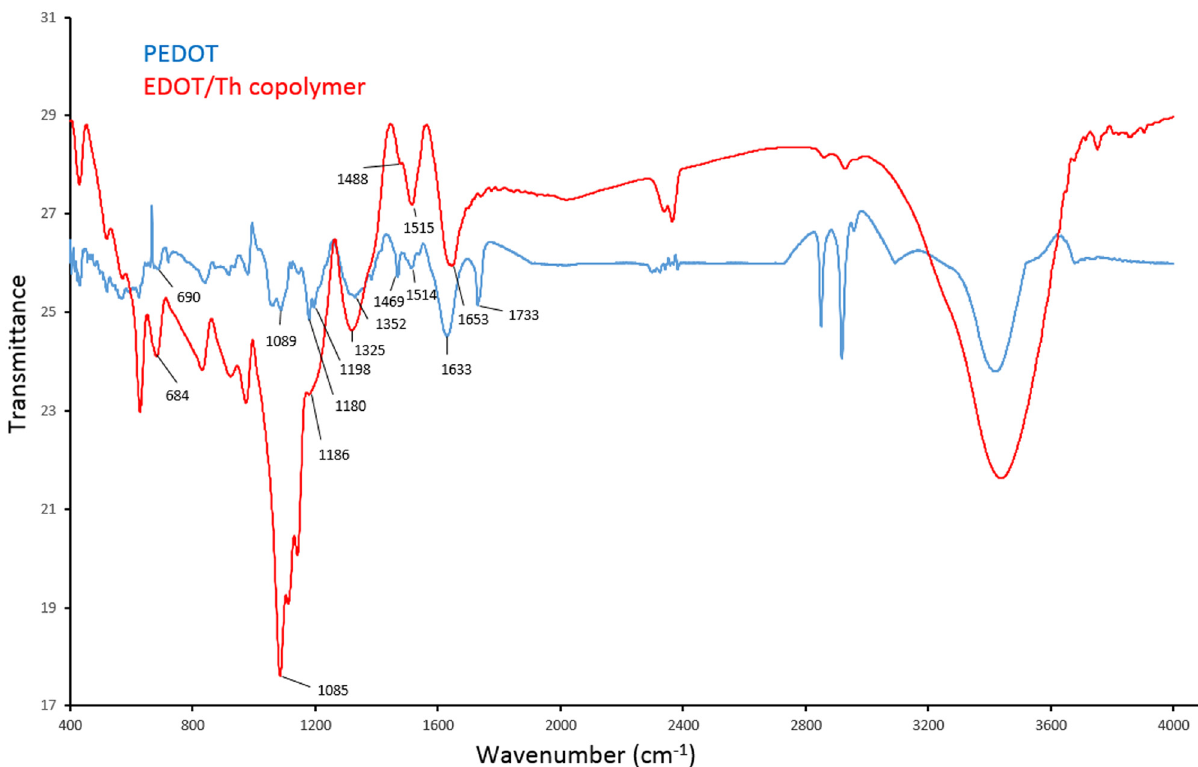
Figure 2: FTIR spectra of PEDOT and EDOT/Th copolymer.